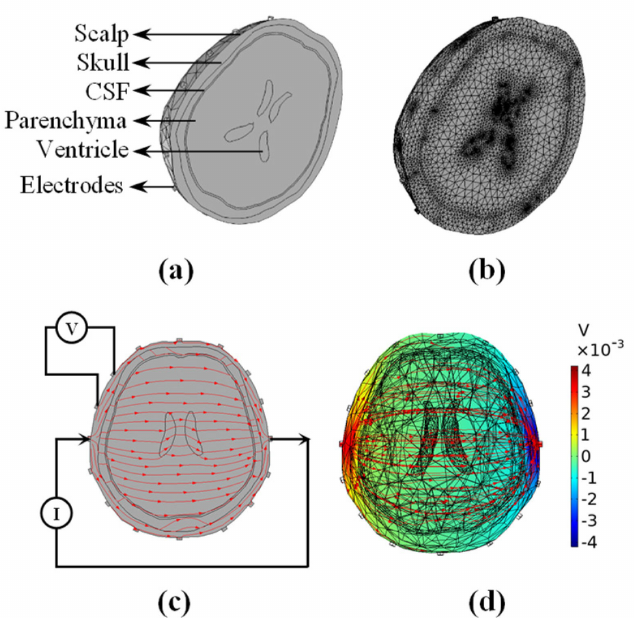
Figure 1. Brain EIT model used for simulation experiment. ( a ) 3D realistic head. ( b ) Discrete finite element mesh. ( c ) A polar drive pattern and red flow lines with arrows represent the current direction. ( d ) Intracranial potential distribution (pseudo-color) and current density lines (red flow lines) under single excitation. (CSF: cerebrospinal